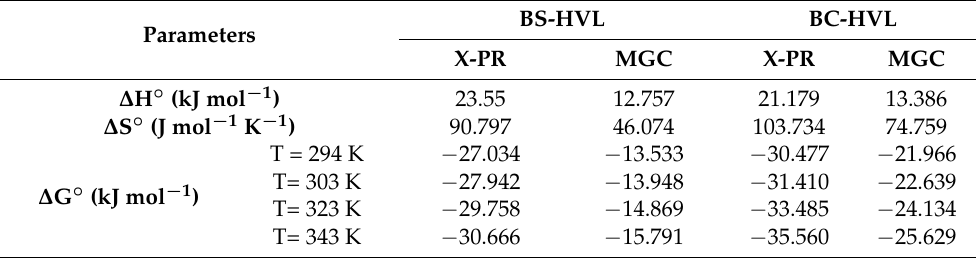
Table 5. Thermodynamic parameters for the adsorption of X-PR and MGC onto BS-HVL and